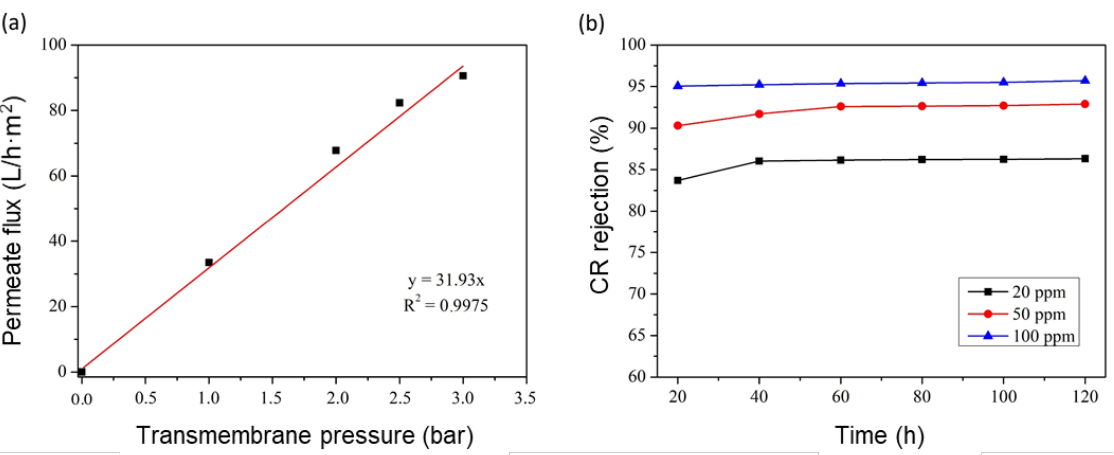
Figure 11. ( a ) Variation in water permeate flux of the GO/phosphate membrane as a function of the transmembrane pressure; ( b ) CR rejection rate as a function of the concentration.